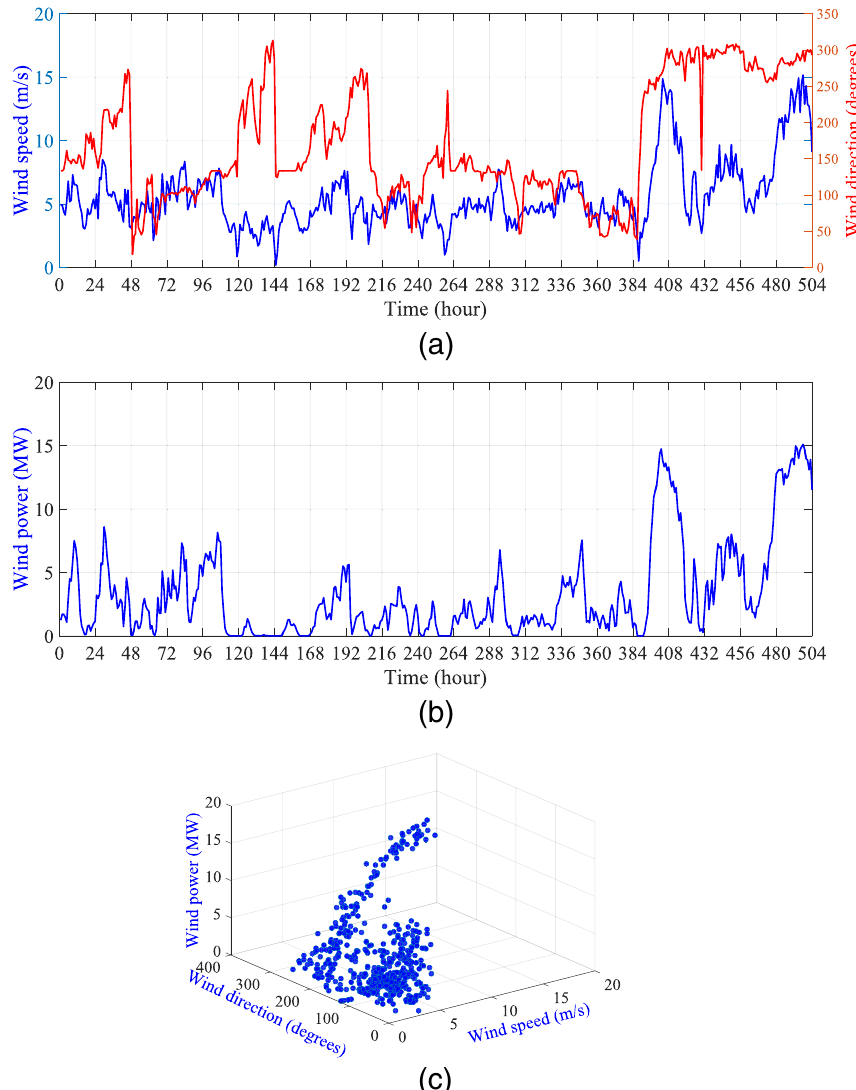
Fig. 5 Sotavento wind farm hourly data from November 17, 2020, to December 07, 2020. a Wind speed and direction profile, b wind power generation, and c wind power with respect to wind speed and